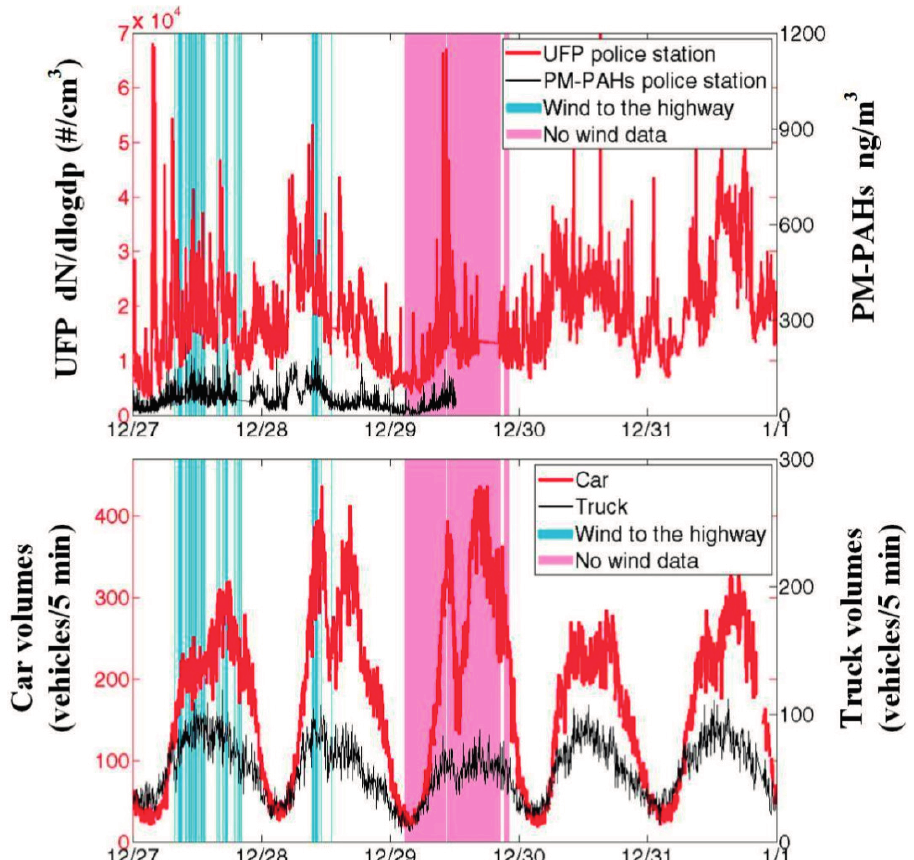
Figure 6. Time series plot of the UFP and vehicle volume throughout the study period. Periods of the color bars (light blue and pink) were not used for analysis since they indicate the wind direction was not from the highway or the data was